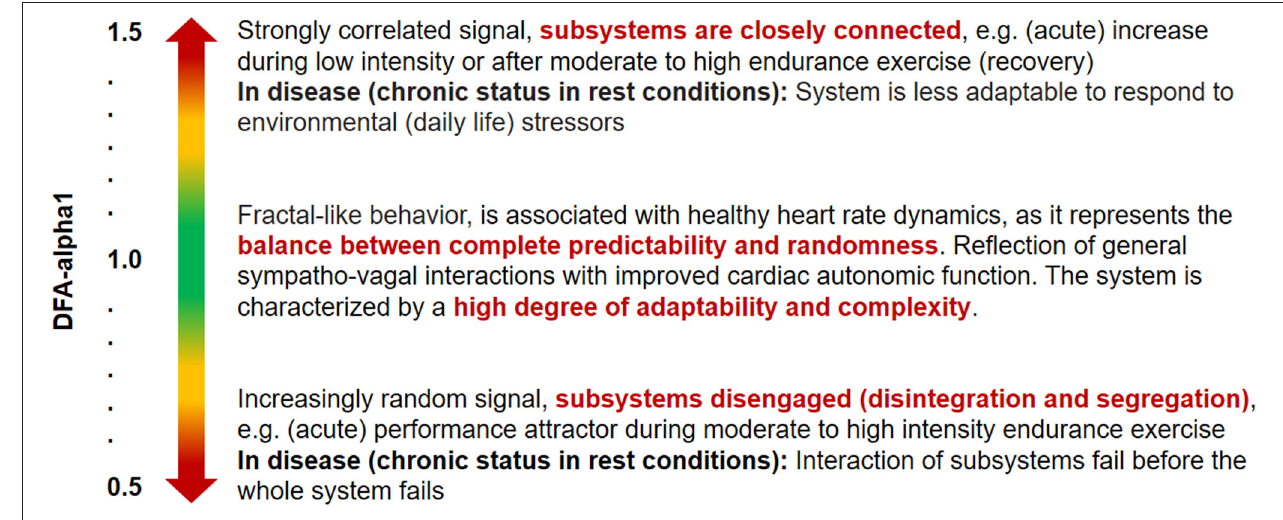
FIGURE 1 | Quantification and qualitative description of acute and chronic correlation properties (short-term scaling exponent alpha1 of DFA) within HR time series during resting conditions and during endurance-type exercise demands ( Peng et al., 1995; Goldberger et al., 2002; Lipsitz, 2002; Tulppo et al., 2003; Gronwald et al., 2018